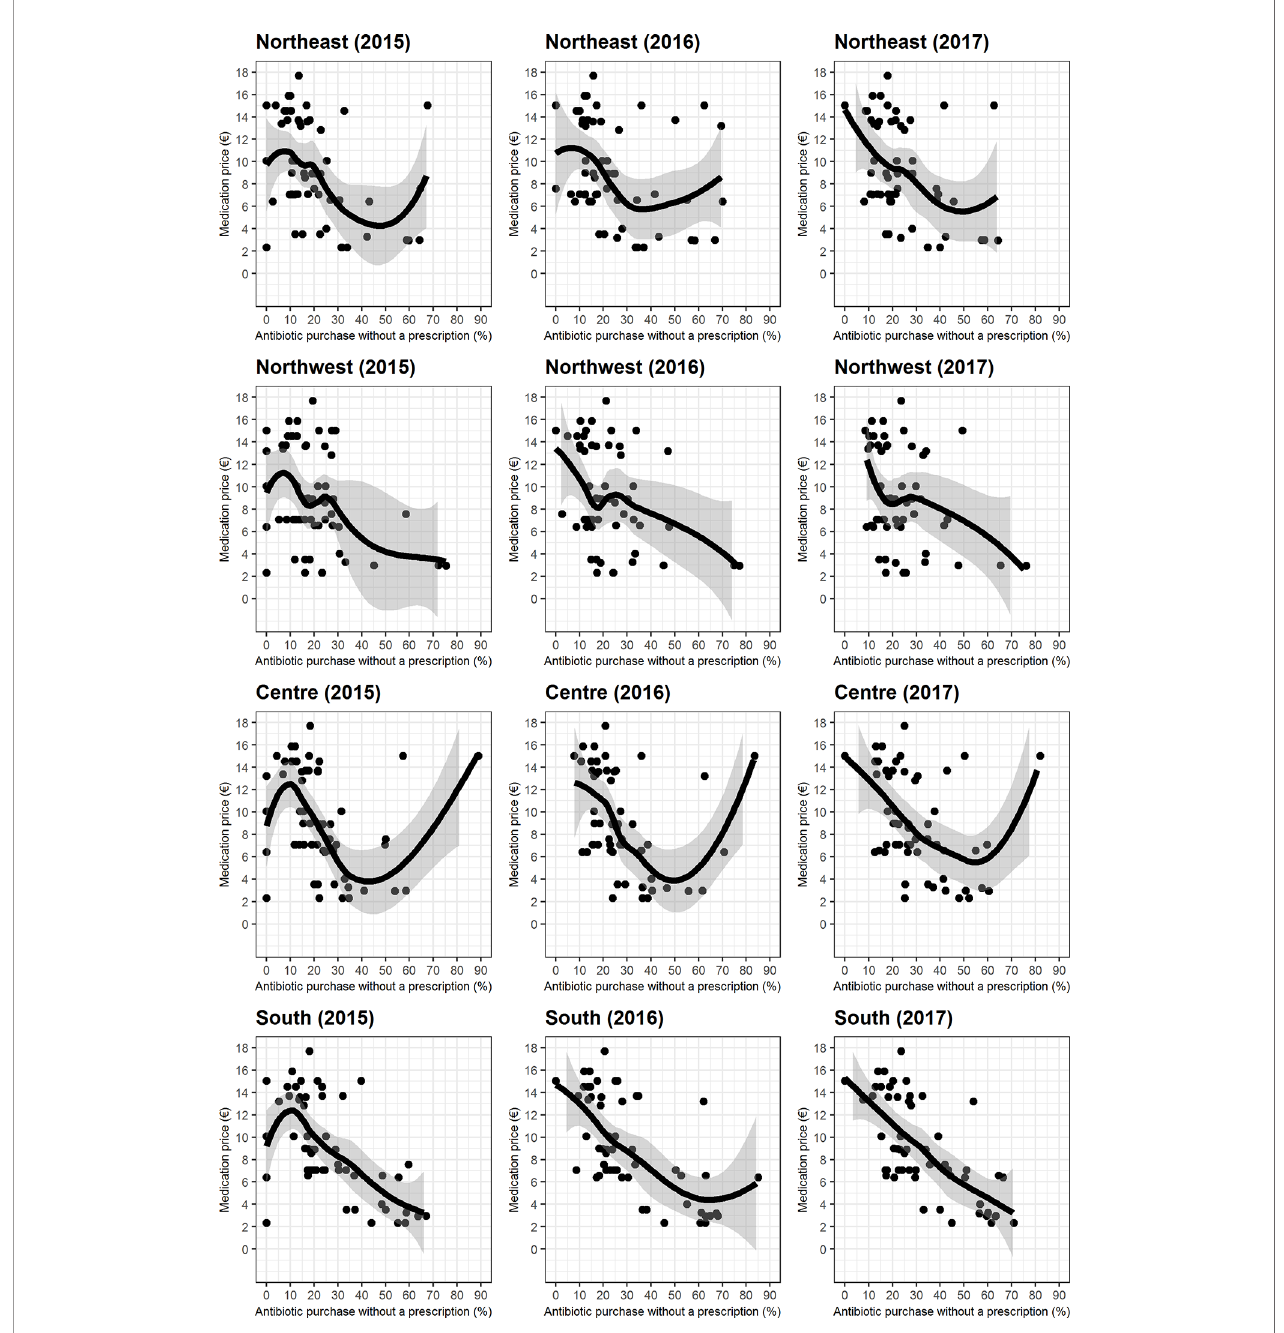
FIGURE 4 | Relationship between medication price and the percentage of the top fi ve pediatric antibiotic purchases without a prescription, along with Locally Estimated Scatterplot Smoothing